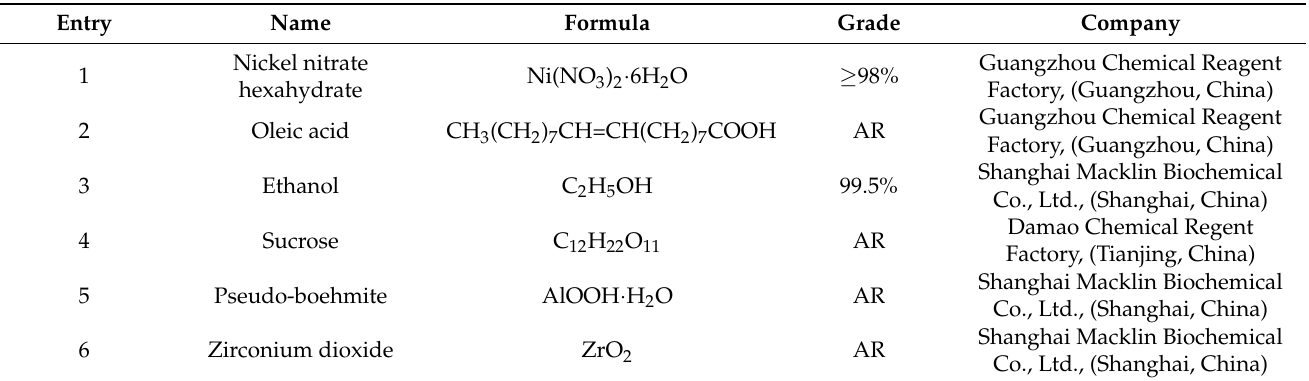
Table 2. Chemical reagents used in this